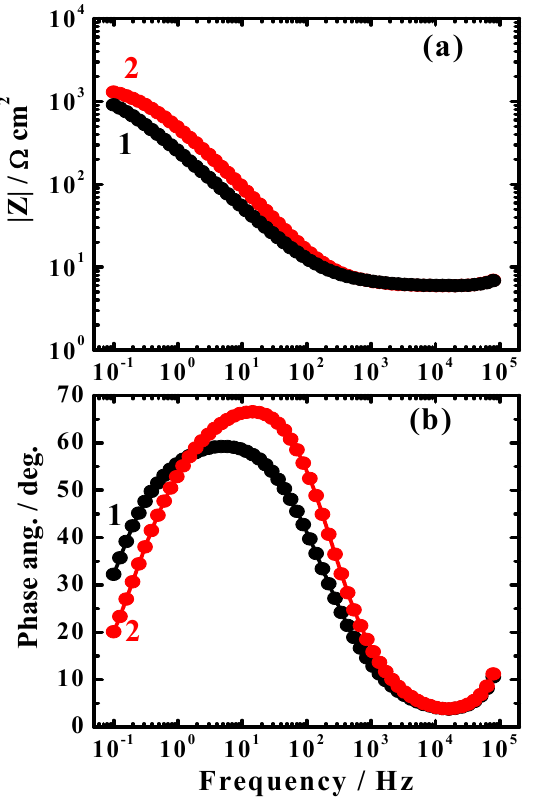
Figure 7. Typical Bode ( a ) impedance of the interface, | Z |; and ( b ) phase angle plots obtained for the cast iron electrode after ( 1 ) 1 h and ( 2 ) 24 h immersion in the AGS solution,